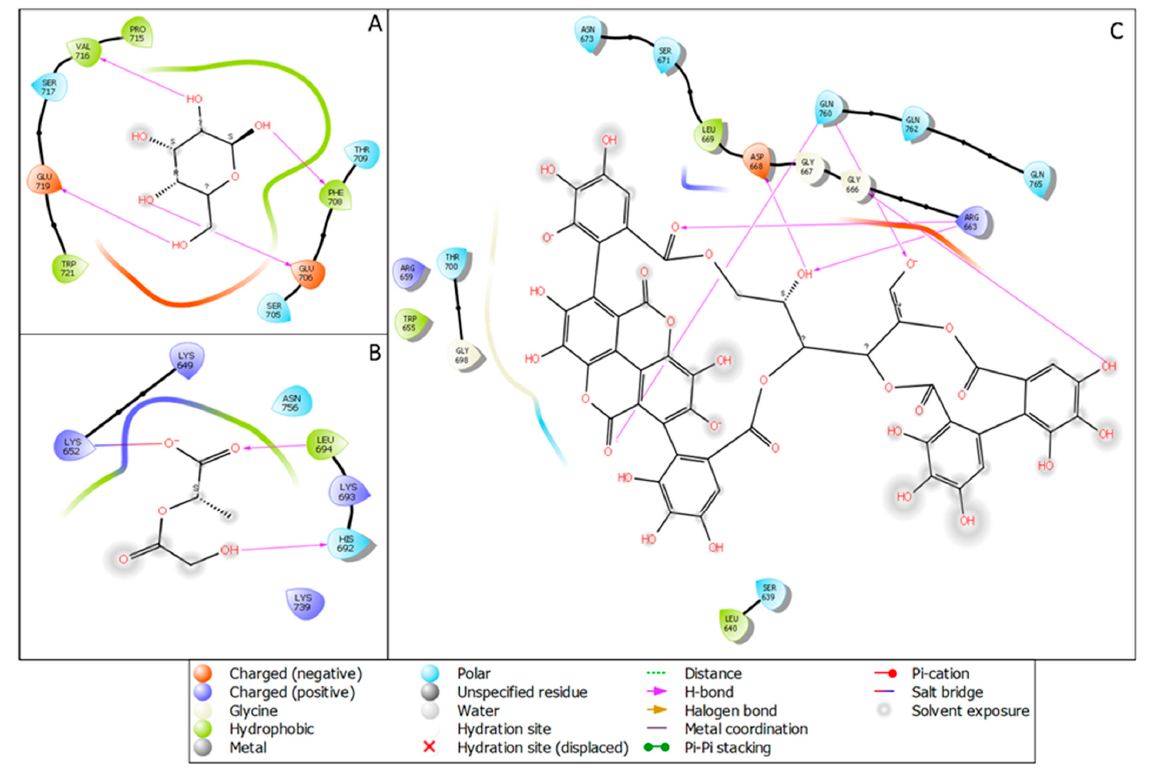
Figure 2. The ligand interaction diagram of the macrophage mannose receptor (1EGI) with ( A ) mannose, ( B ) PLGA and ( C ) punicalagin. Table 1. The docking score MM\GBSA score and other energies of the protein–ligand